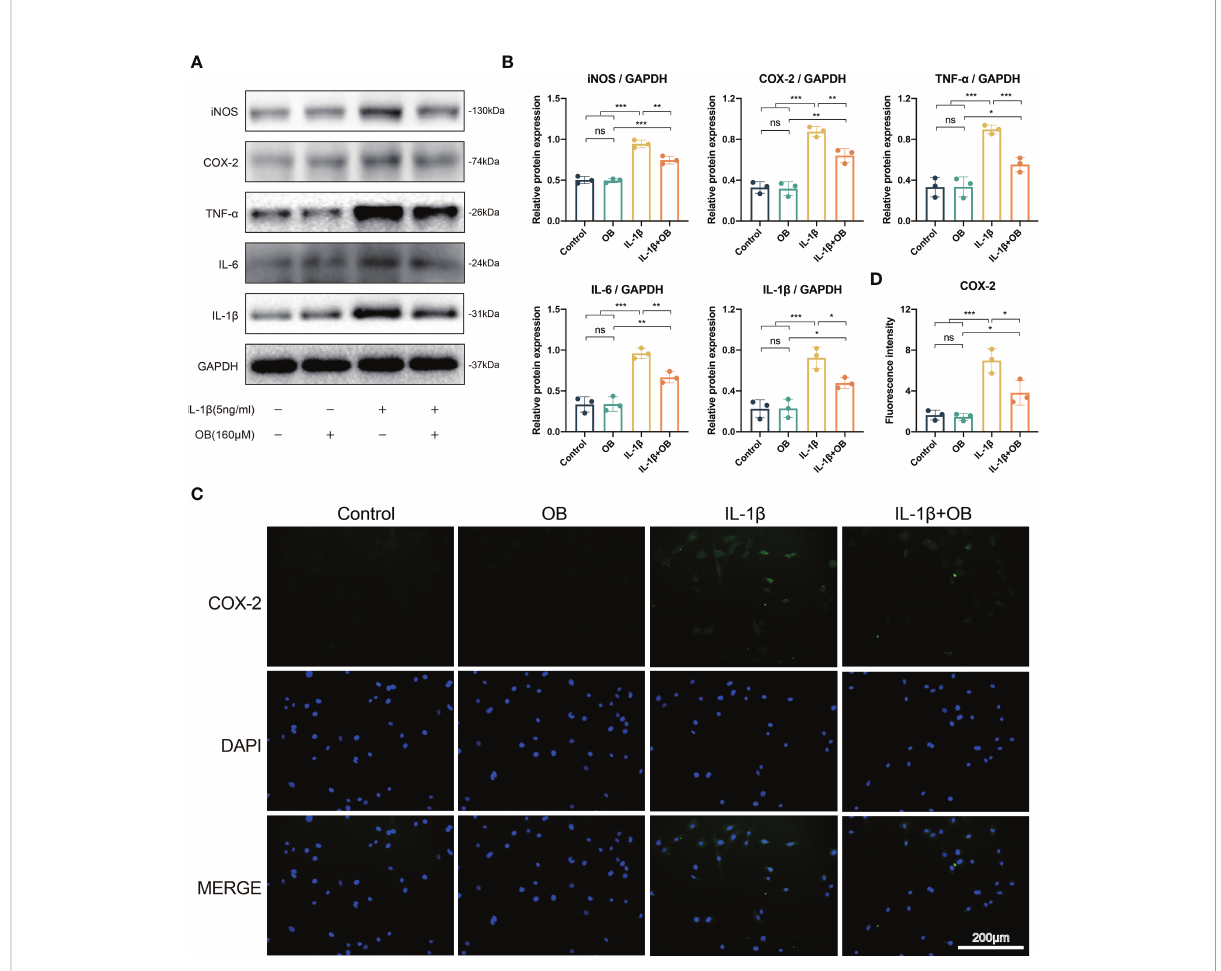
FIGURE 4 OB attenuated the in fl ammatory responses in IL-1 b – induced chondrocytes. Chondrocytes were administered with IL-1 b (5 ng/ml) or/and OB (160 m M) for 24 h. (A) Western blot analysis and (B) quantitative data for in fl ammatory proteins (iNOS, COX-2, TNF- a , IL-6, and IL-1 b ) in chondrocytes. (C) Immuno fl uorescence staining and (D) quantitative analysis of the expression levels of COX-2. Data were presented as means ± SD (n = 3). ns, no signi fi cance; * p < 0.05; ** p < 0.01; *** p <